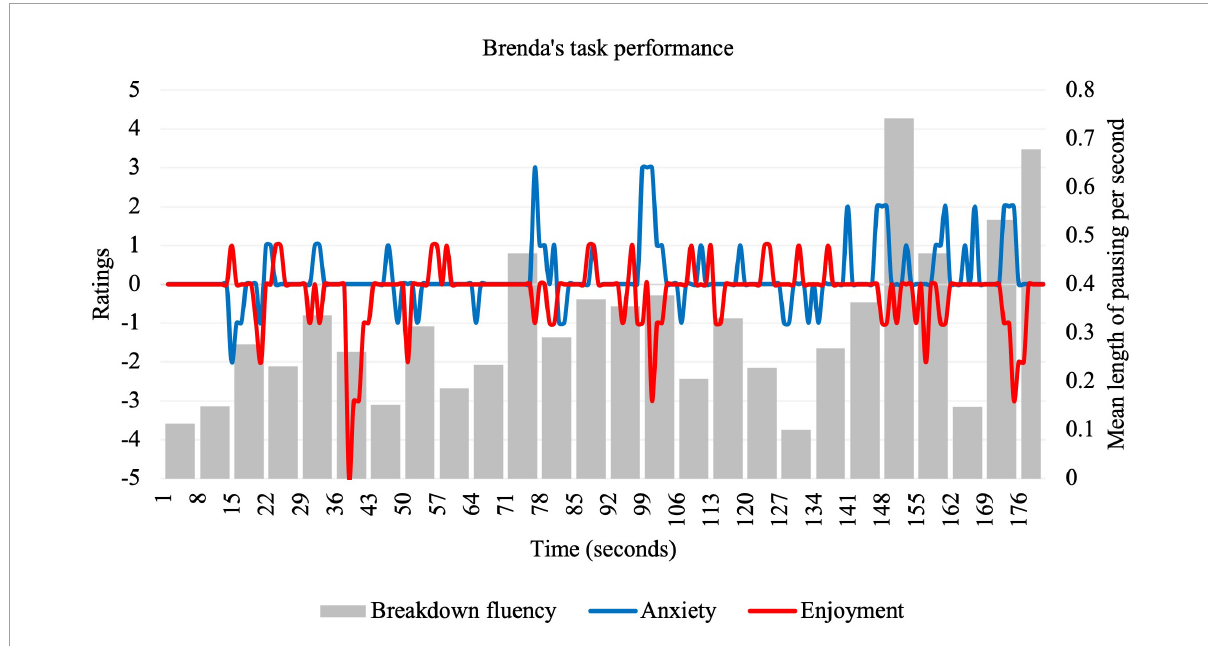
FIGURE3 Idiodynamic ratings and breakdown fluency per segment for Brenda’s task